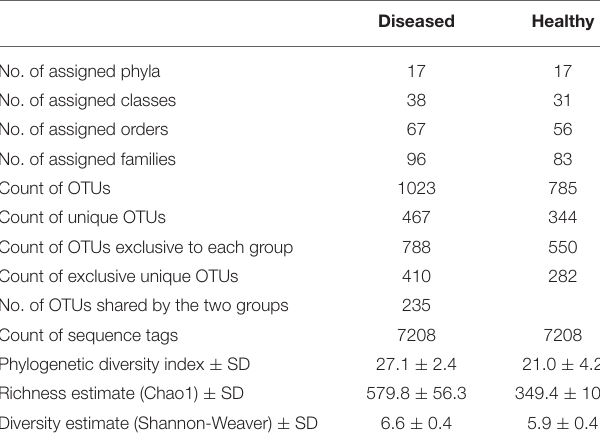
TABLE 1 | Summary of the bacterial diversity found by pyrosequencing of the apparently healthy and the diseased tissues of SGA-affected P. carnosus colonies.